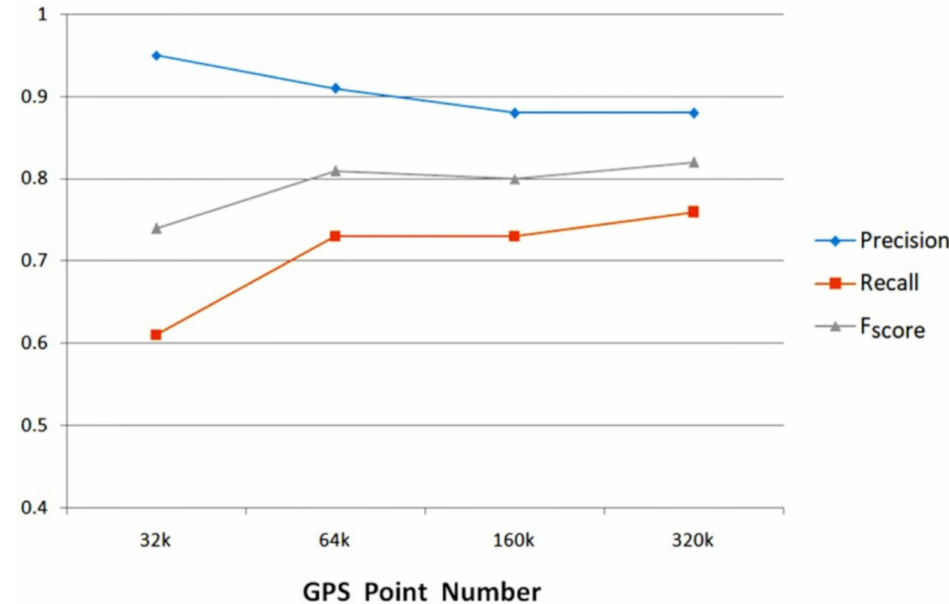
Figure 14. Detection quality using di ff erent numbers of GPS